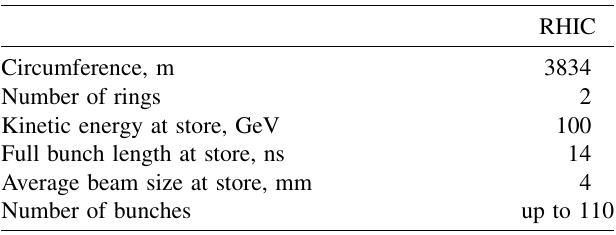
TABLE I. Main machine and beam parameters relevant to past proton runs at